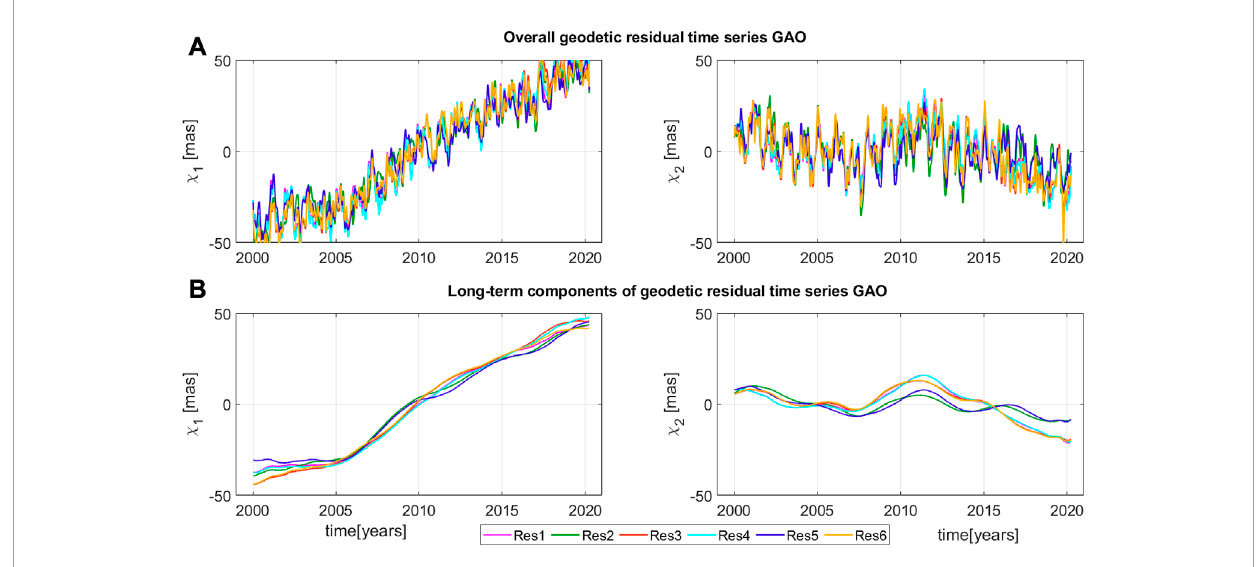
FIGURE 1 Time series of χ 1 and χ 2 equatorial components of overall (A) and long-term oscillations (B) of geodetic residuals computed from different combinations of mass and motion terms of AAM and OAM models (Res1, Res2, Res3, Res4, Res5, Res6). Long-term oscillations was computed using MSSA method for the signals reconstruction with oscillations bigger than 10 years.